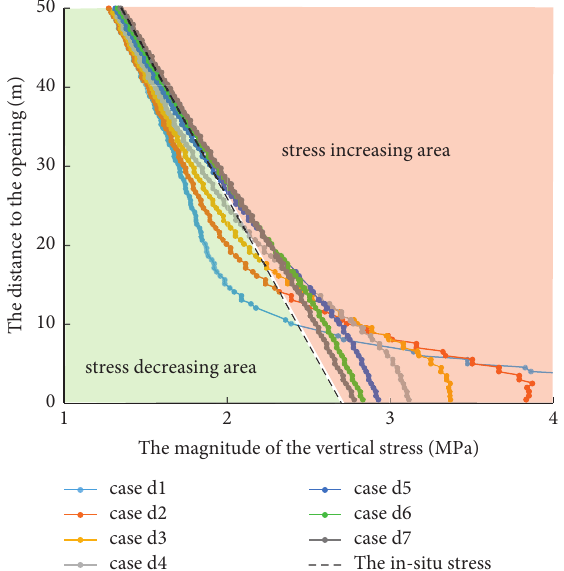
Figure 11: The relationship between the vertical stress and the distance to the